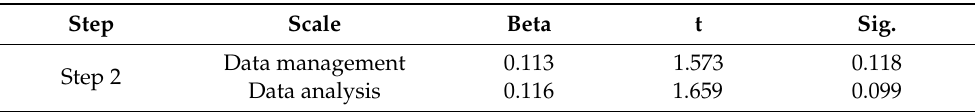
Table 11. Variables outside the regression equation to predict brand internationalization by applying business intelligence